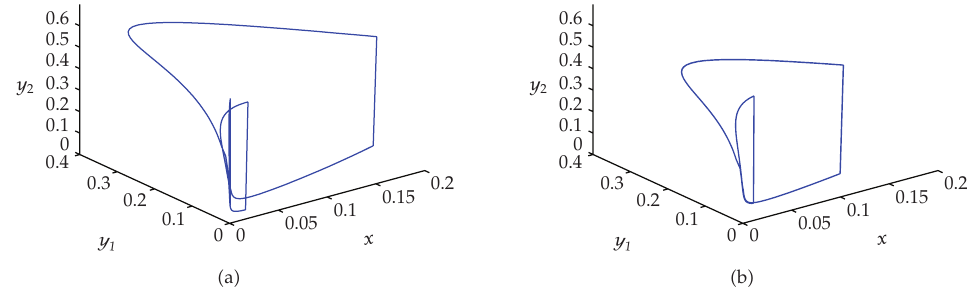
Figure 4: Nonunique attractor at T (cid:6) 13 . 7: (cid:2) a (cid:3) Phase portrait of 3 T -periodic solution with initial values x (cid:6) 8 . 5 , y 1 (cid:6) 4 . 8 , y 2 (cid:6) 2 . 8. (cid:2) b (cid:3) Phase portrait of 2 T -periodic solution with initial values x (cid:6) 18 . 5 , y 1 (cid:6) 14 . 8 , y 2 (cid:6) 12 .